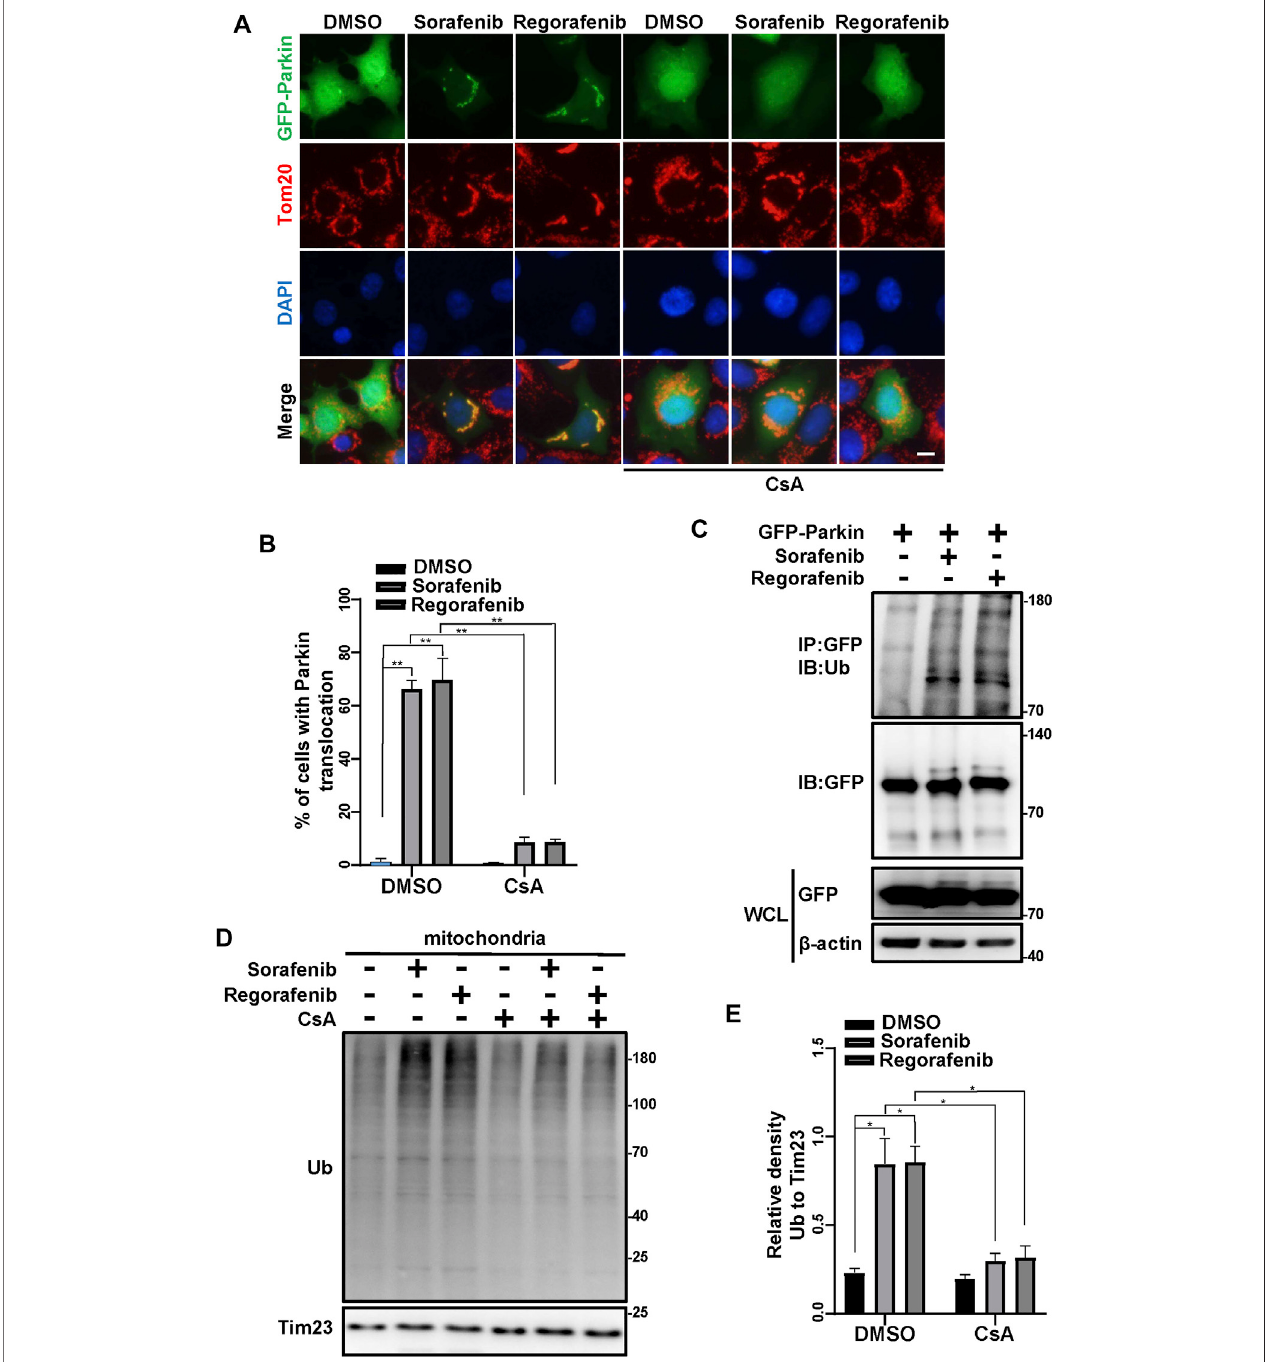
FIGURE 3 | Sorafenib and regorafenib activate Parkin via mPTP opening. (A) HEK293 cells were transfected with EGFP-Parkin for 24 h. After pretreatment with CsA (20 μ M) for 1 h, the cells were then treated with sorafenib (20 μ M) or regorafenib (30 μ M) for 4 h. Immuno fl uorescence of EGFP-Parkin is shown (blue, DAPI; green, EGFP-Parkin; red, Tom20; scale bar, 10 μ m). (B) The density of cells with GFP-Parkin translocation as in A was quanti fi ed. Values are the mean ± SEM from three independentexperiments(** p < 0.01,two-wayANOVAandTukey ’ smultiplecomparisonstest). (C) WesternblotsshowingParkinubiquitinationinHepG2cellsthat were transfected with EGFP-Parkin for 24 h and then treated with sorafenib or regorafenib for 4 h. The cell lysates were subjected to immunoprecipitation assays and western blotting with the indicated antibodies. (D) HepG2 cells were pretreated with CsA (20 μ M) for 1 h or not and then treated with sorafenib (20 μ M) or regorafenib (30 μ M) for 4 h. The mitochondrial fractions were separated using a mitochondrial isolation kit. The ubiquitinated protein levels in the mitochondria were detected using western blotting. (E) The relative densitiesof ubiquitination were quanti fi ed, with the protein level normalized to the loading controls (Tim23). Values are the mean ± SEM from three independent experiments (* p < 0.05, two-way ANOVA and Tukey ’ s multiple comparisons test).